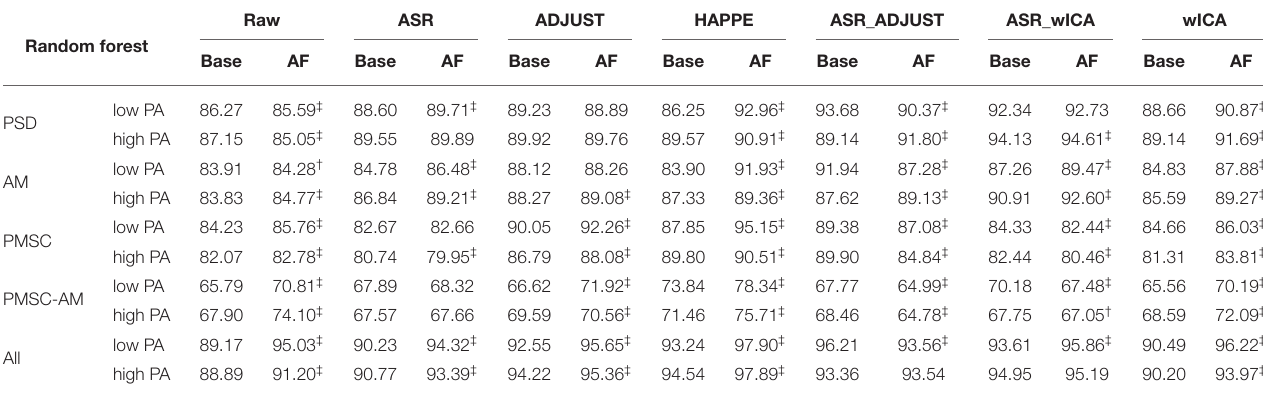
TABLE 1 | RF mental workload classification accuracy for different feature and enhancement algorithm configurations. Raw ASR ADJUST HAPPE ASR_ADJUST Random forest